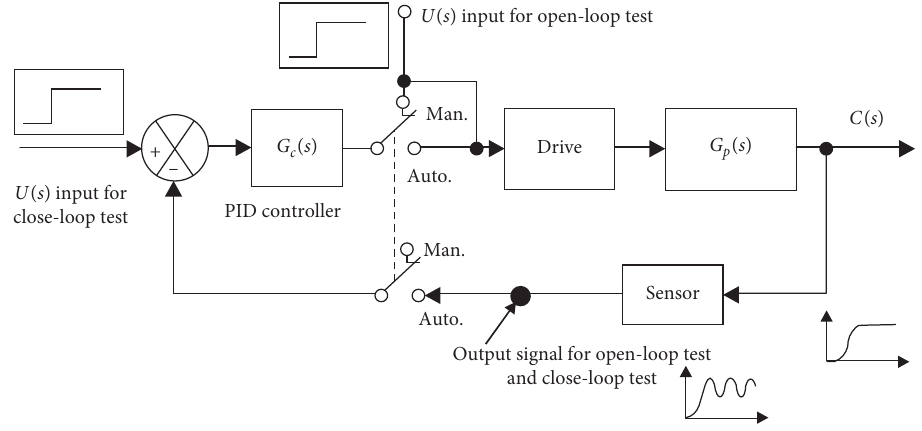
Figure 2: Z-N ′ open-loop and closed-loop methods. Table 1: Z-N tuning rule based on step response of plant by the open-loop method [21]. Type of controller